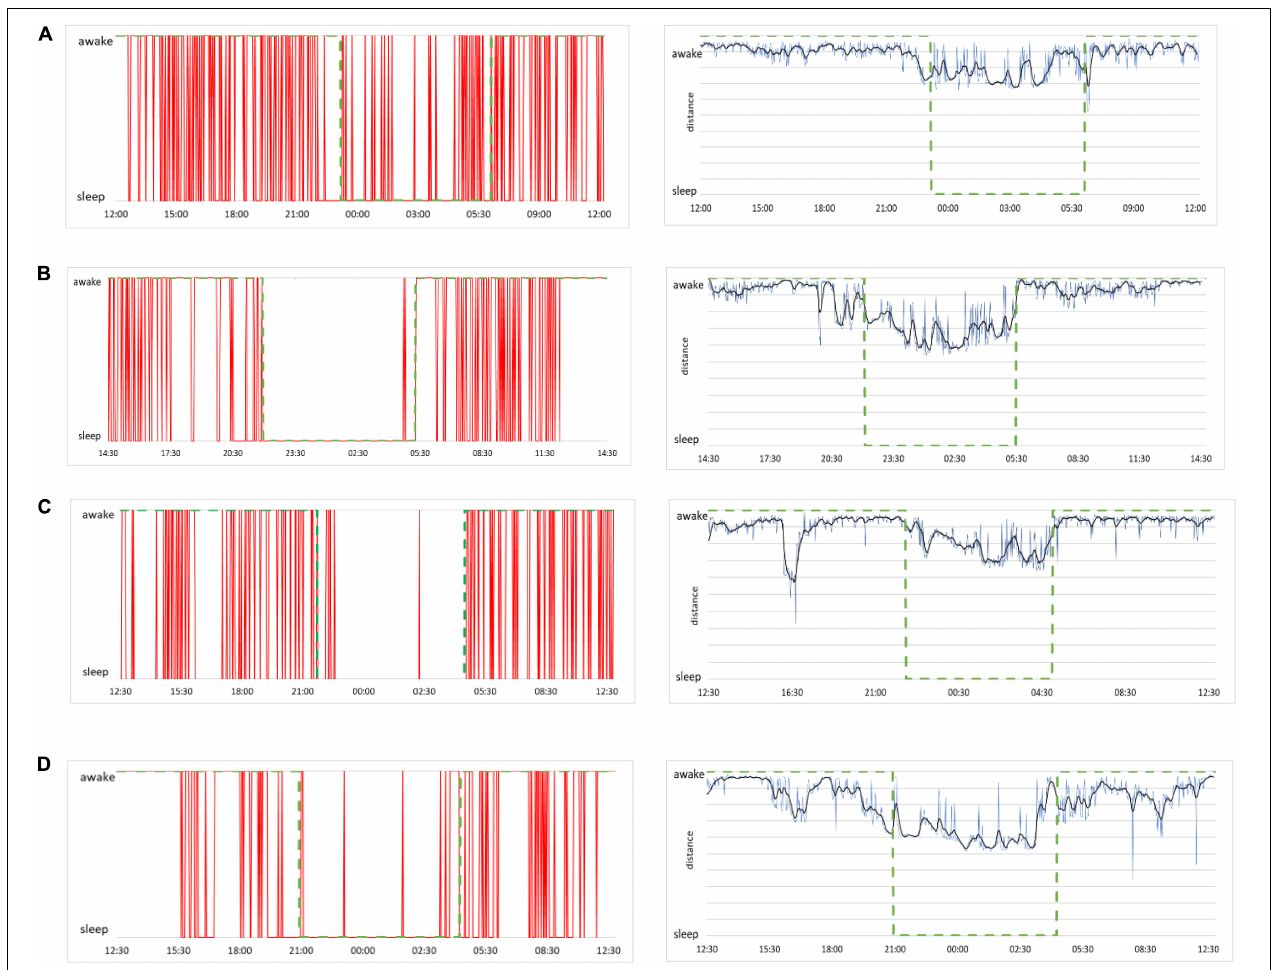
FIGURE 9 | ( A , left) Sleep and awake stages determined by our method for the case of a male subject, 21 years of age. Red lines indicate consciousness status as a binary value (sleep or awake) as a function of time over 24 h of measurement. ( A , right) Raw data of distances from the best shapelet as function of time for the same subject (blue line), smoothed via Butterworth filter (black line) for better clarity. Green dashed line shows the self-reported information in both plots. (B) The same plots for a female subject, 23 years of age, (C) a male subject, 49 years of age, and (D) a female subject, 50 years of